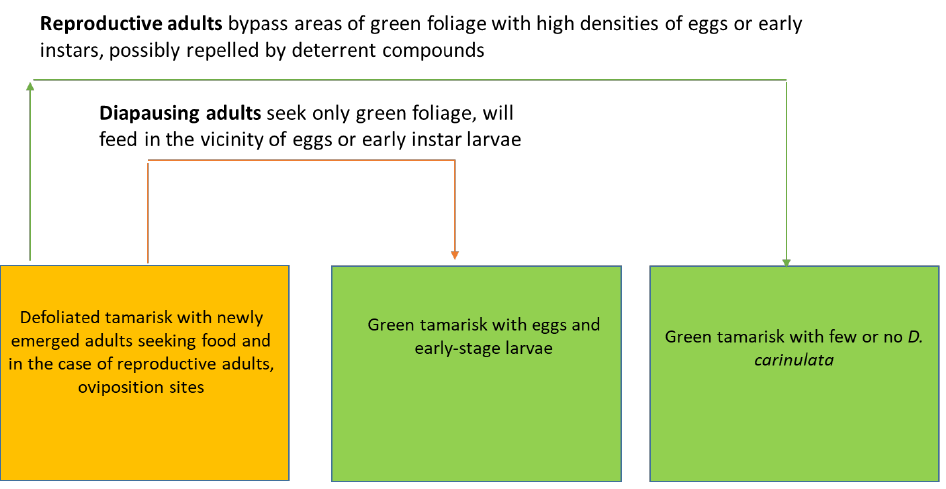
Figure 4. Schematic representation of dispersing D. carinulata adults moving out of defoliated areas and seeking green tamarisk for feeding and oviposition (reproductive state) or simply feeding (diapause destined state).